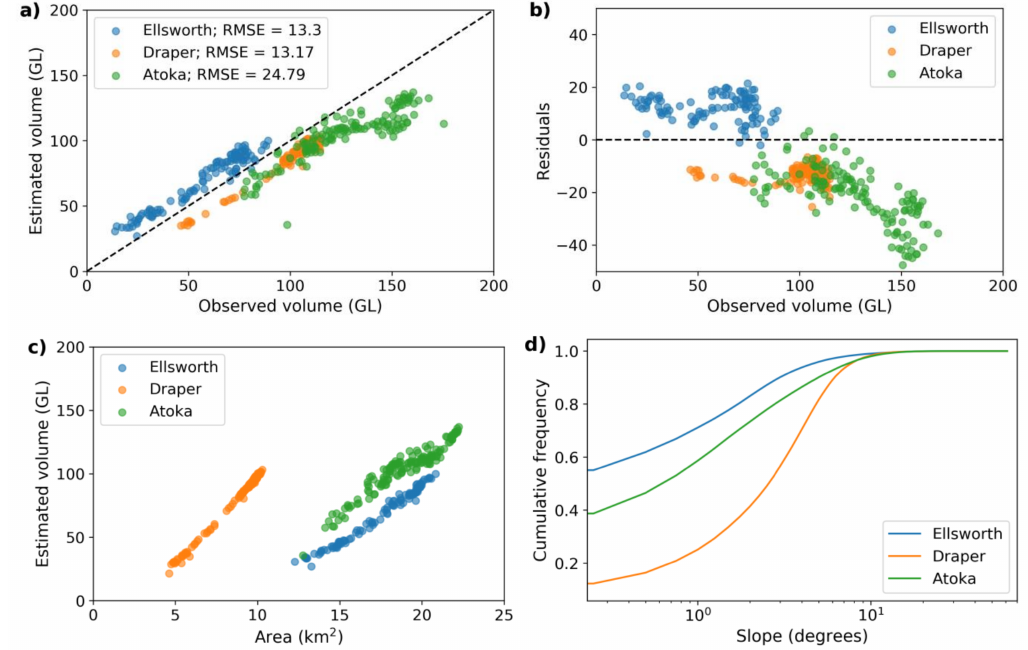
Figure 10. Water volume estimations ( a ), their residuals ( b ), and the area–volume relationship ( c ) obtained using the inverse distance weighting interpolation methodology on the Oklahoma reservoirs. The cumulative frequency of slopes in the reservoirs is also presented ( d